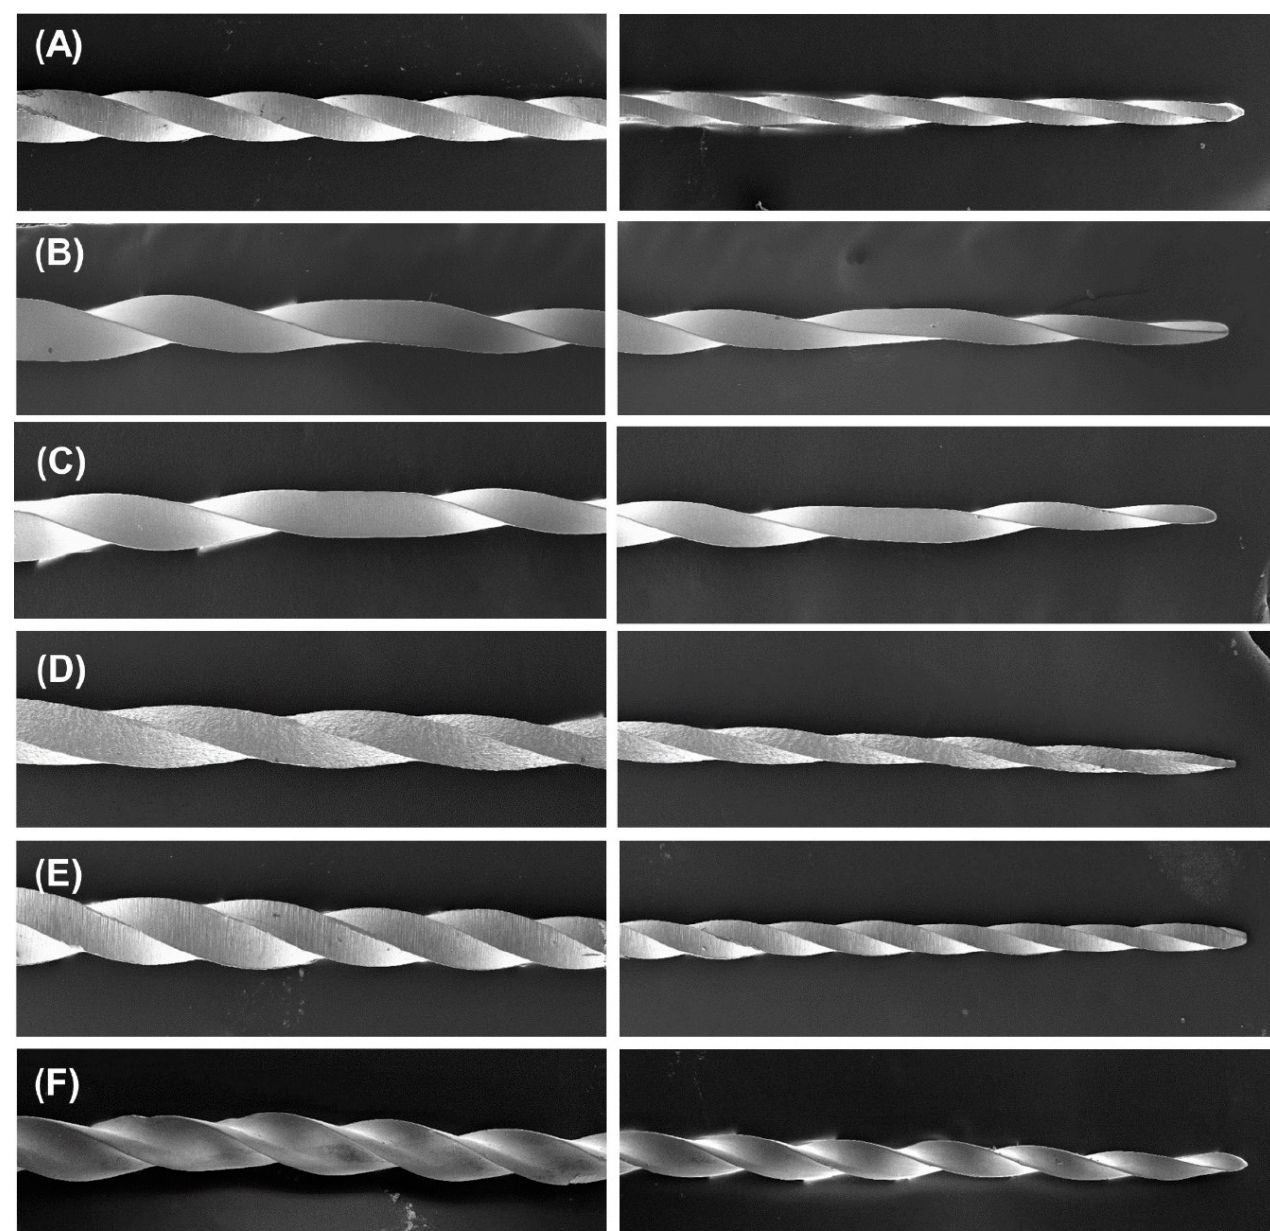
Figure 2. SEM images of unused NiTi rotary glide path files. Coronal flutes (left images, ~5–9 mm from tip) and apical cutting surfaces (right images, ~0–4 mm of tip) of PathFile ( A ), RaCe ( B ), RaCe Evo ( C ), HyFlex EDM ( D ), TruNatomy Glider ( E ), and V Taper 2H ( F ), are shown (×30 magnification).